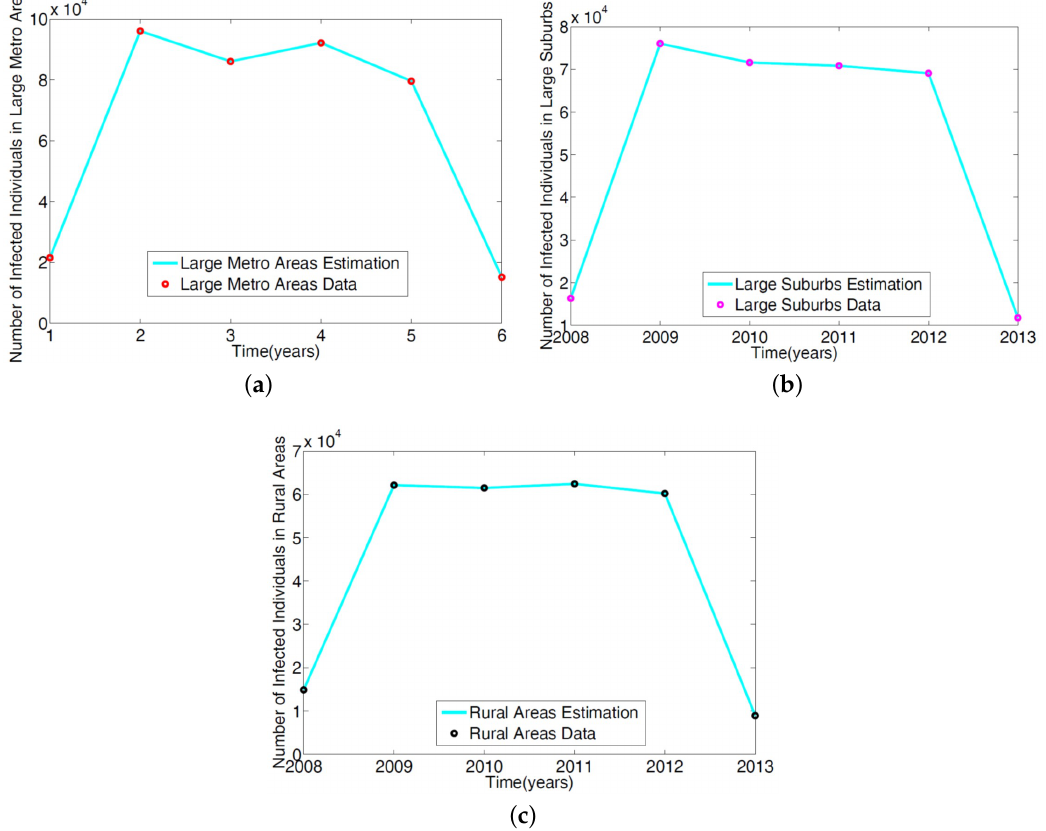
Figure 3. Simulation of the non-IDUs reduced MRSA model given in Wagner [14] was fitted to the ICD-9 MRSA data for: ( a ) Large metropolitan data; ( b ) large suburbs area data; ( c ) rural area